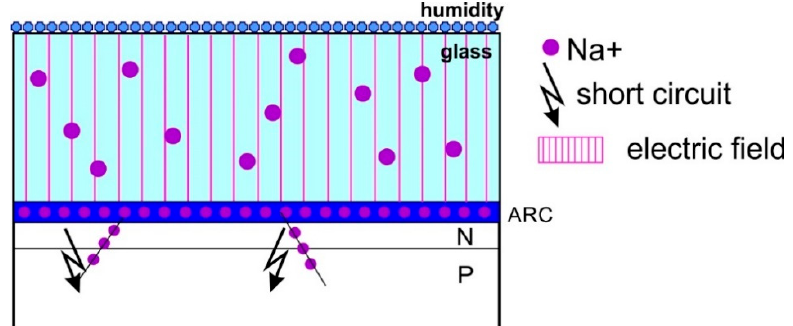
Figure 2. PID polarization scheme.